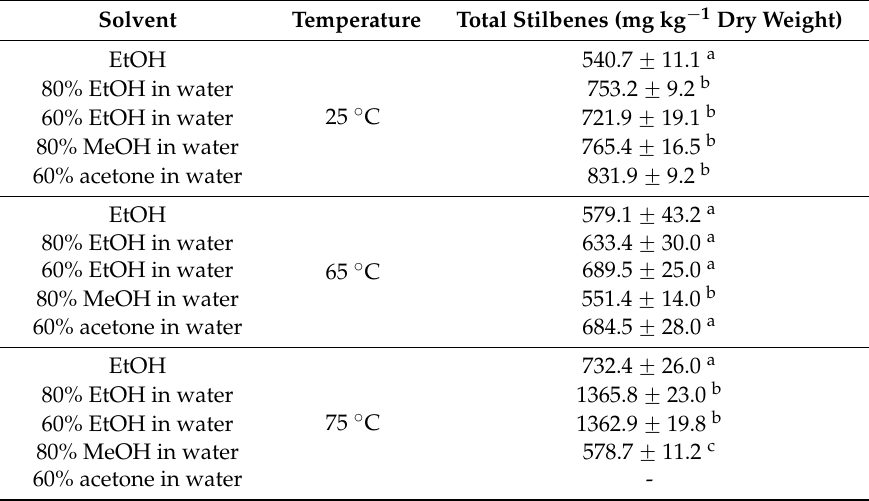
Table 1. Effects of different solvents on the extraction of total stilbenes ( n =